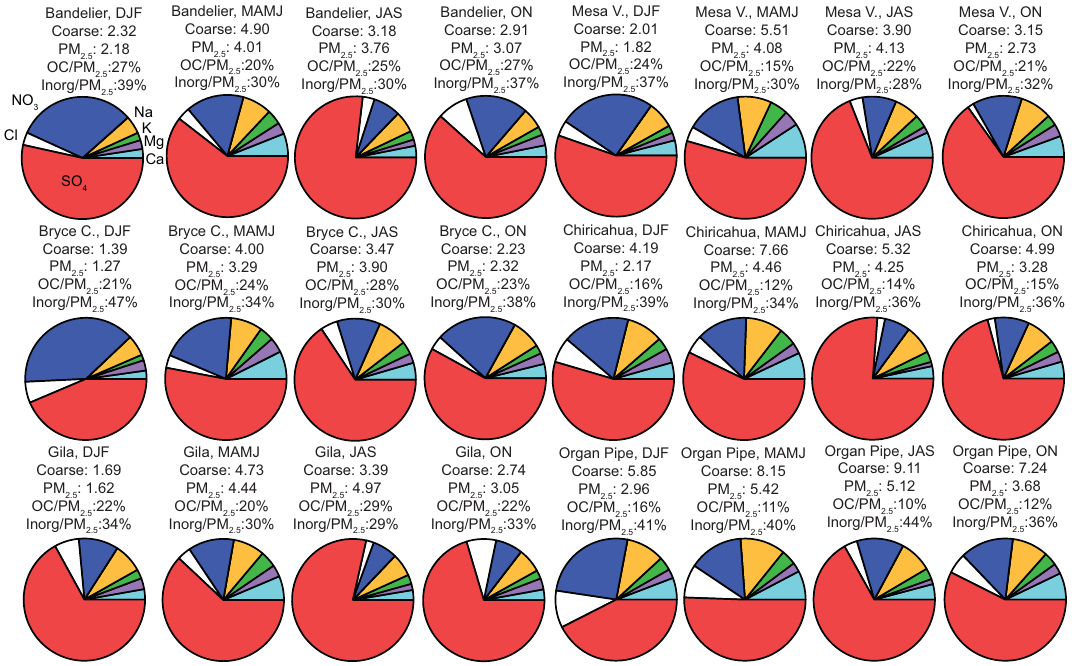
Fig. 5. Average monthly mass fractions of selected PM 2 . 5 constituents for all six IMPROVE sites and for four seasons. The labels for each color in the top left pie are the same for the other pies. Also reported are average PM 2 . 5 and coarse aerosol concentrations in units of µgm − 3 , the concentration ratio of OC to PM 2 . 5 , and the concentration ratio of the sum of the seven inorganic components of the pies (”Inorg”) relative to PM 2 . 5 . These results are based on data ranges in Table 1 for each